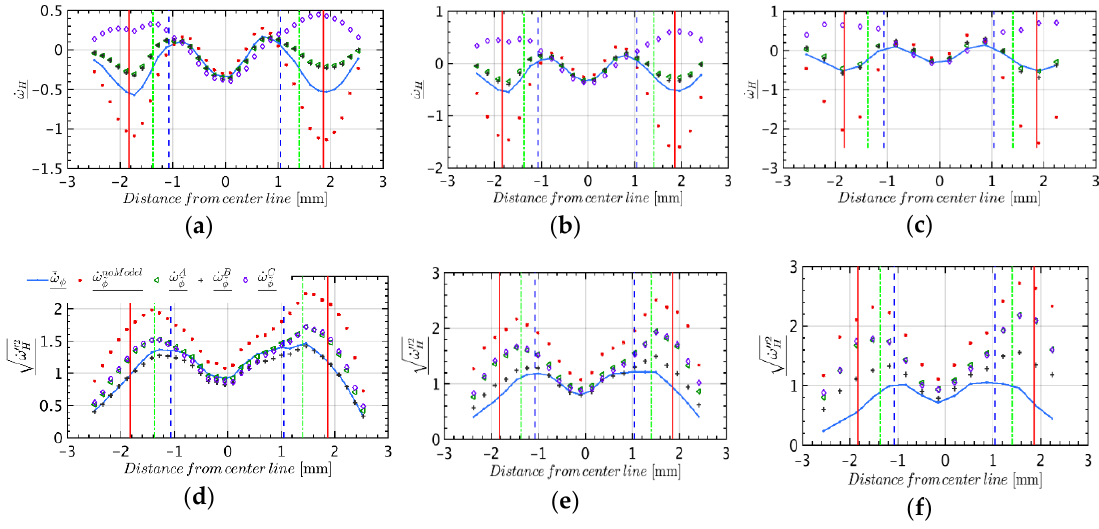
Figure 4. Production/consumption rate of H with units (kg/(m 3 s)): ( a , b , c ) Mean; and ( d , e , f ) RMS. Different filter widths are applied: ( a , d ) ∆/∆ DNS = 8; ( b , e ) ∆/∆ DNS = 12; and ( c , f ) ∆/∆ DNS = 18. The data are extracted at 𝑡 = 20𝑡 𝑗 . Vertical lines are the same as in Figure 3.